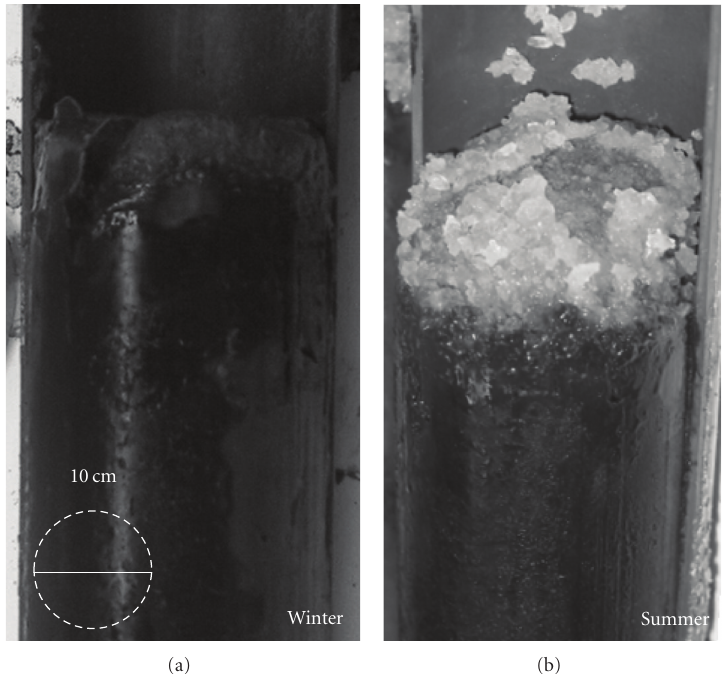
Figure 2: Cores of sediments of Tirez ephemeral lagoon for analysis collected from winter and summer showing the dark zone in the upper region probably due to metal sulfide precipitation. The evaporite is founded in summer